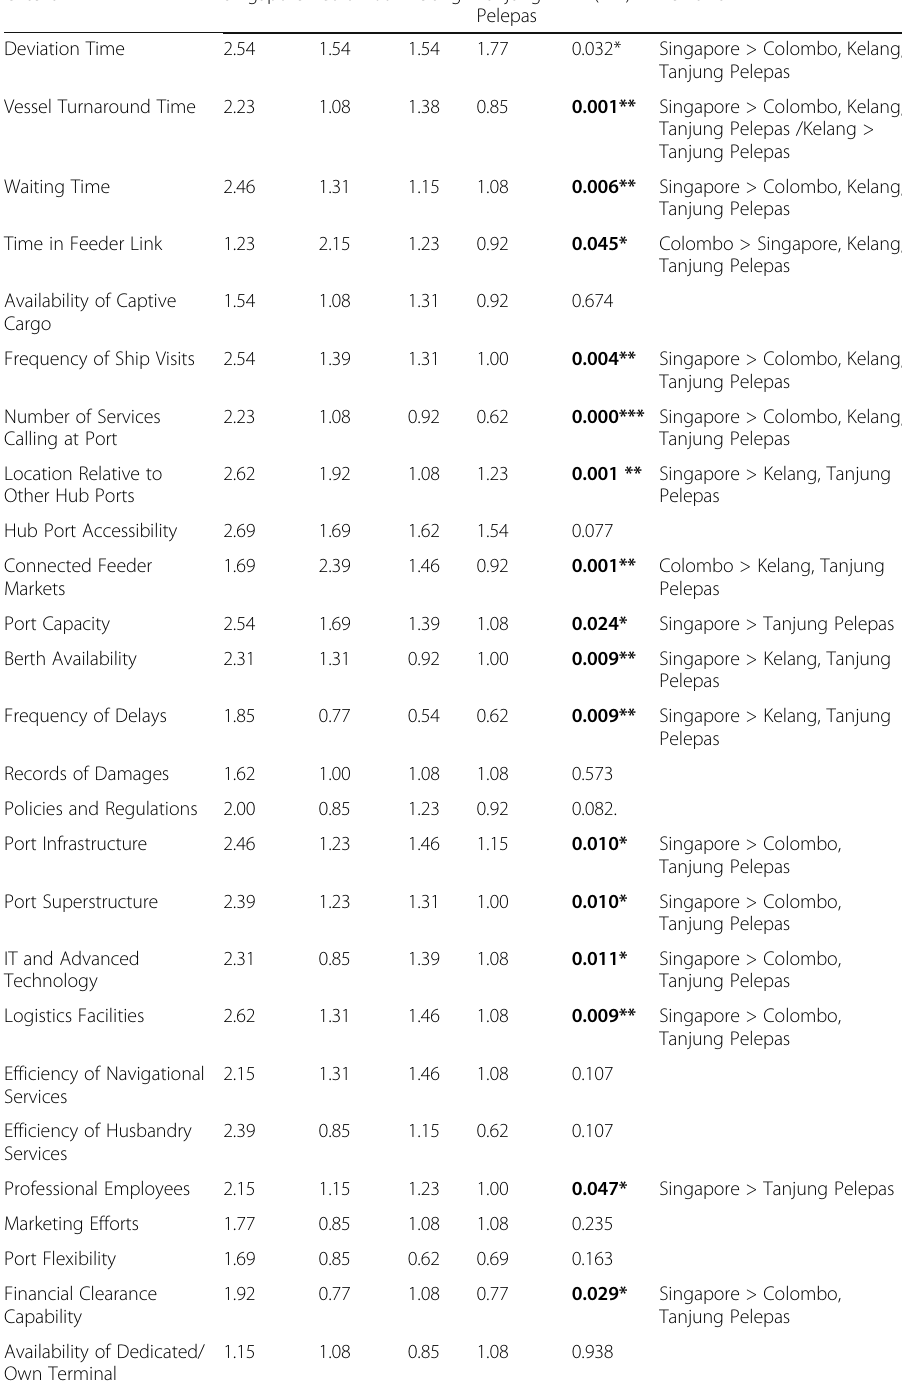
Table 12 Average Appreciation Scores (AvAS) of Hub Ports